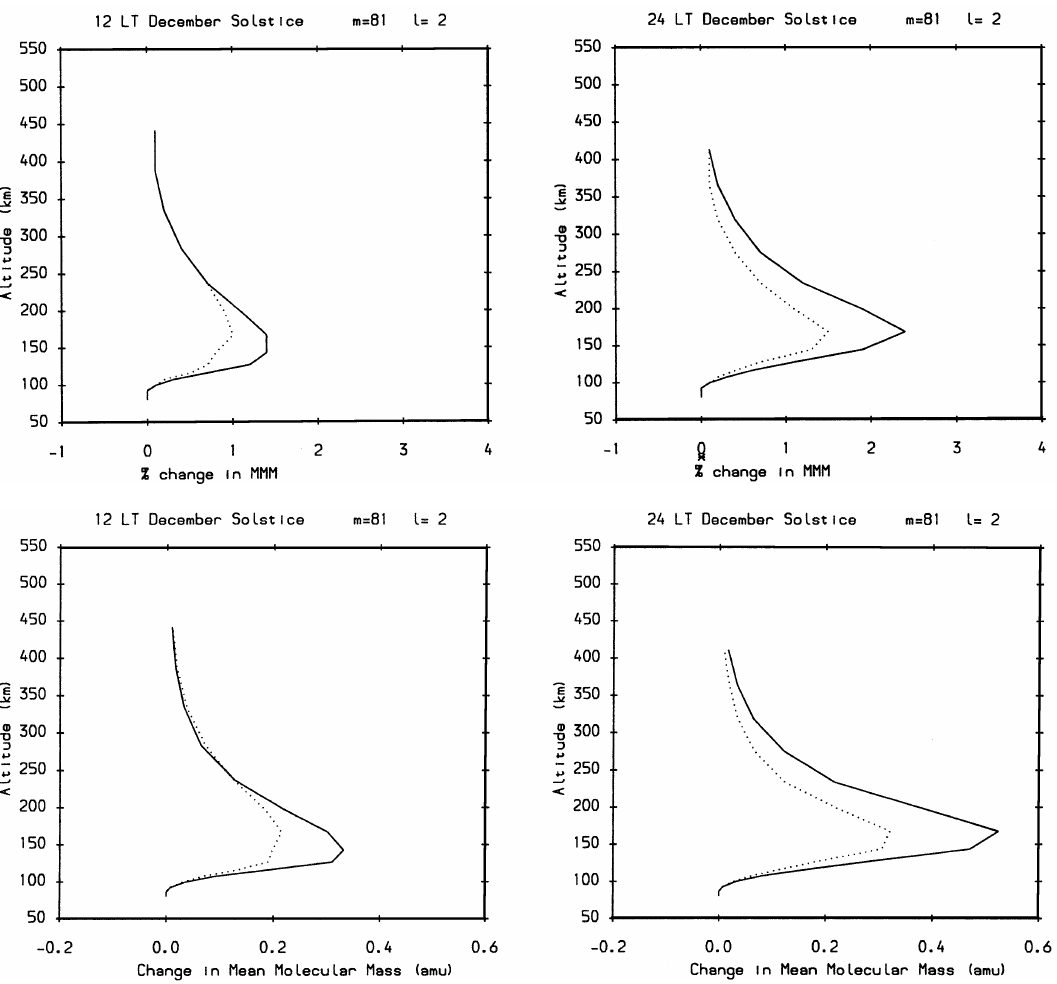
Fig. 6. Altitude profiles of the change of mean molecular mass ( MMM ) at local noon and midnight over EISCAT. The solid (broken) lines represent the change from (cid:15) 6 = 1 to (cid:15) 6 = 1 . 4 ( (cid:15) 6 = 1 .